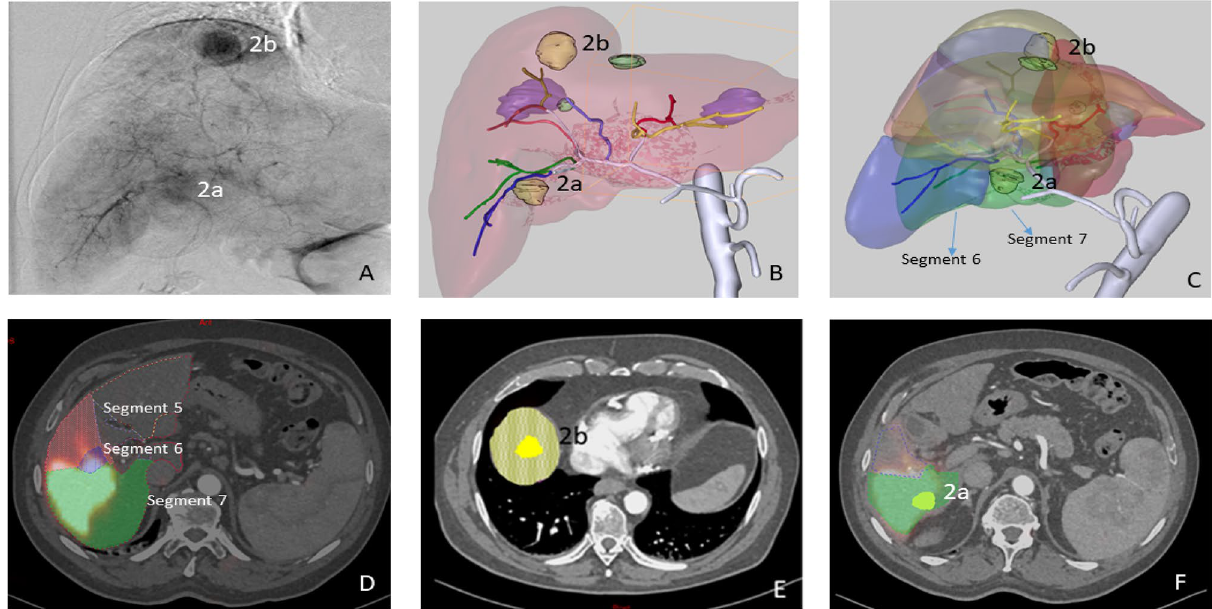
Figure 3. Patient 2. HCC with two hypervascular nodules in the arteriography study ( A ). MeVis study showing the arterial and liver segment territories ( B , C ) as well as the tumoral nodules (2a irrigated only by segment 7 artery and 2b only by segment 8 artery). Since the treatment was administered through 5–6 and 7–8 segment arteries, 90 Y-microspheres deposition was seen in segments 5, 6, 7 ( D , F ) and 8 ( E ) in the MeVis liver segmentation fused on co-registered PET-pCT